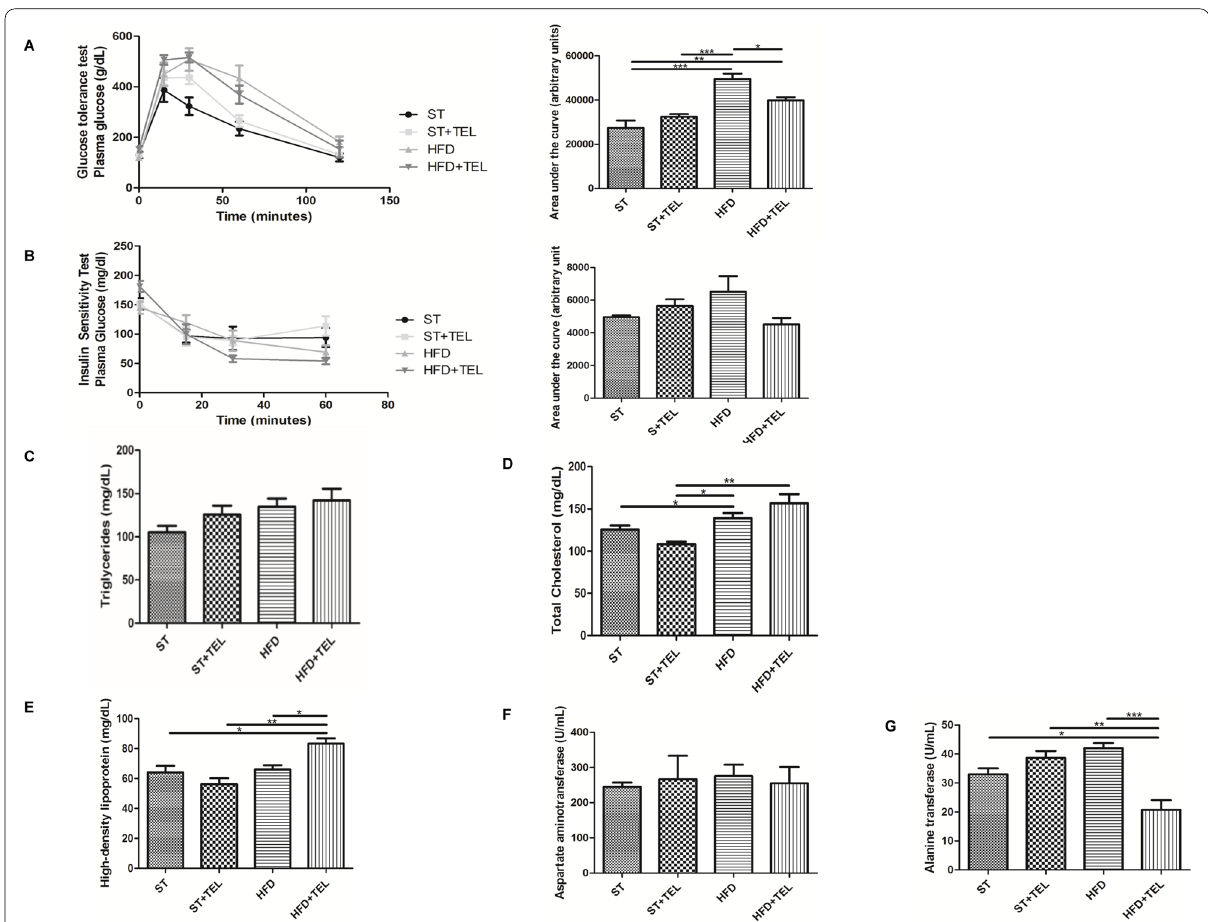
Fig. 3 Insulin sensitivity and glucose tolerance tests, lipid parameters, and hepatic enzymes in mice treated with Telmisartan and fed with a standard and high-fat diet (ST, ST TEL, HFD, HFD TEL). Glucose tolerance test ( a ), insulin sensitivity test ( b ), triglycerides ( c ), total cholesterol ( d ), + + high-density lipoprotein ( e ), aspartate aminotransferase ( f ), and alanine transferase ( g ). Data are presented as the mean and *** p <0.001 versus the group